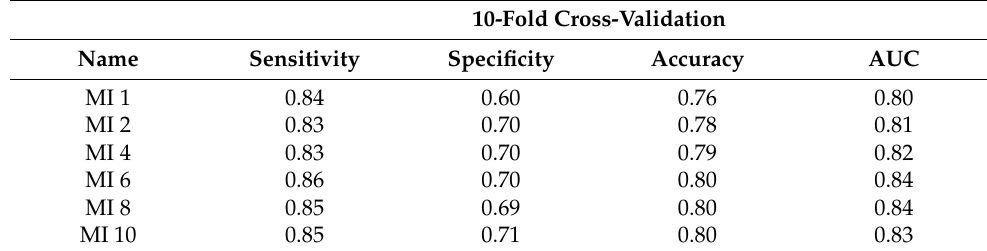
Table 8. SVM classification results using selected feature subsets between normal and glaucomatous eyes.